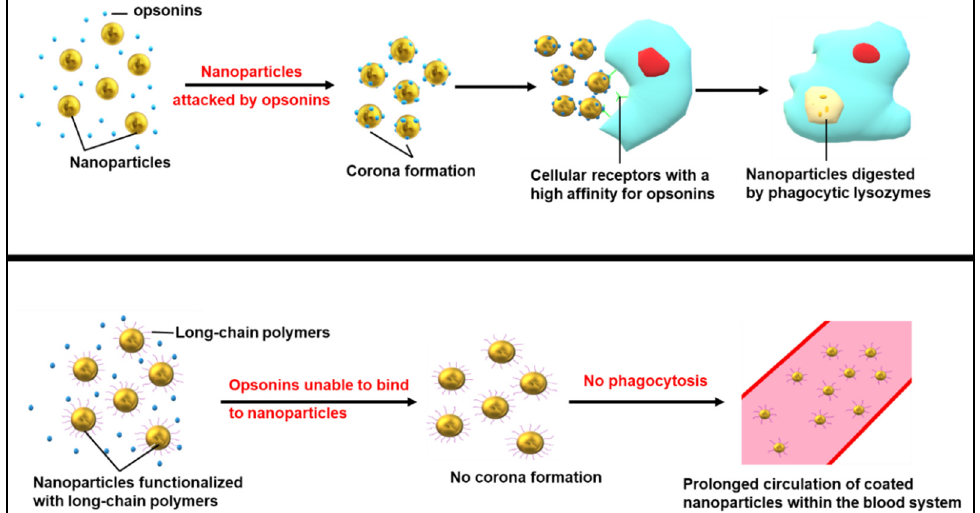
Figure 5. Prevention of nanoparticle opsonization using long-chained polymers such as polyethylene glycol.